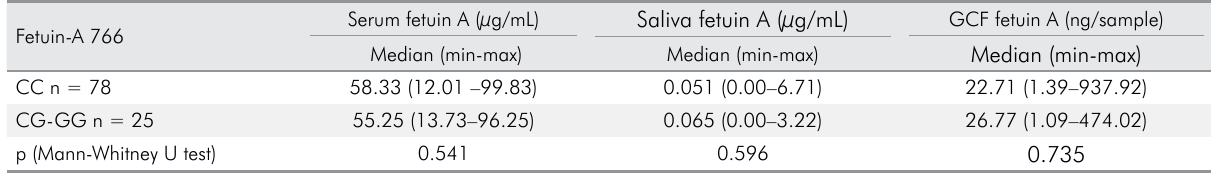
Table 4. Median, minimum and maximum levels of Fetuin-A in serum, saliva and gingival crevicular fluid (GCF) of patients according to fetuin-A 766 genotypes.